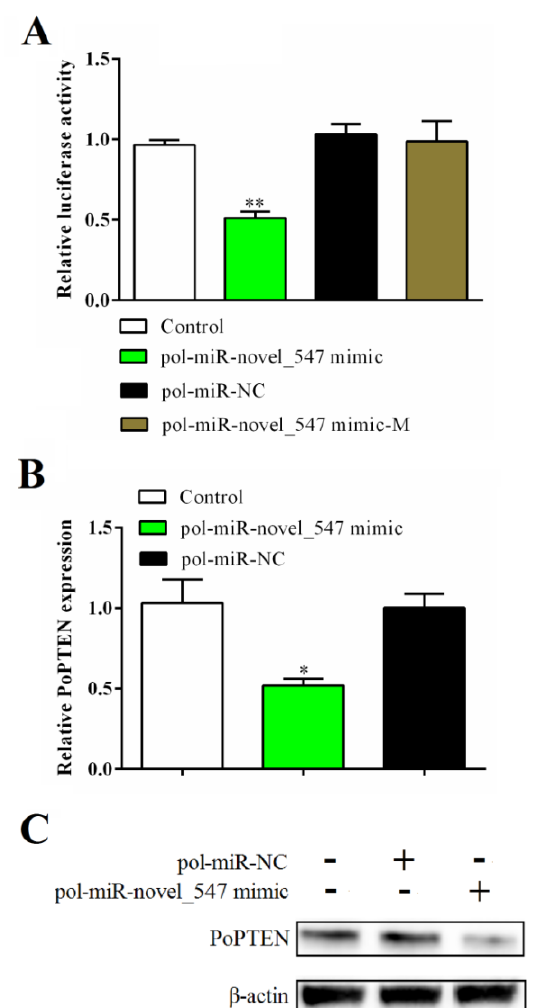
Figure 2. Regulation of PoPTEN expression by pol-miR-novel_547. ( A ) HEK293T cells were transfected with pPTEN-Report in the absence (control) or presence of pol-miR-novel_547 mimic, pol-miR-NC (negative control of pol-miR-novel_547), or pol-miR-novel_547 mimic-M (mutant of pol-miR-novel_547). Relative luciferase activity was determined at 24 h after transfection. ( B , C ) FG-9307 cells were transfected with or without (control) pol-miR-novel_547 mimic or pol-miR-NC, and PoPTEN expression was determined by qRT-PCR ( B ) or Western blot ( C ) with β-actin as a loading control. The values of ( A ) and ( B ) are the means of triplicate experiments and shown as means ± SEM. * p < 0.05; ** p < 0.01.